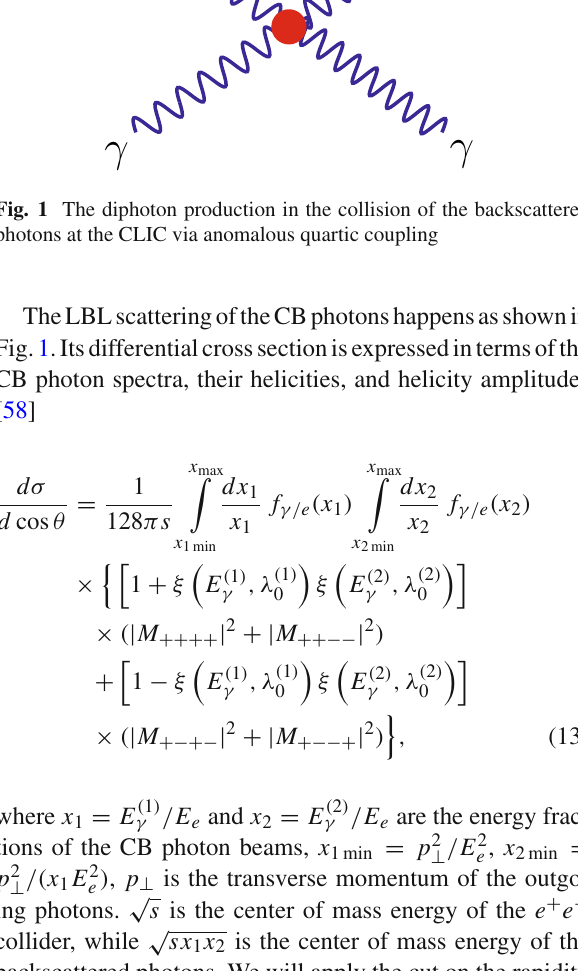
Table 1 The CLIC energy stages and integrated luminosities for the unpolarized and polarized initial electron beams L , fb − 1